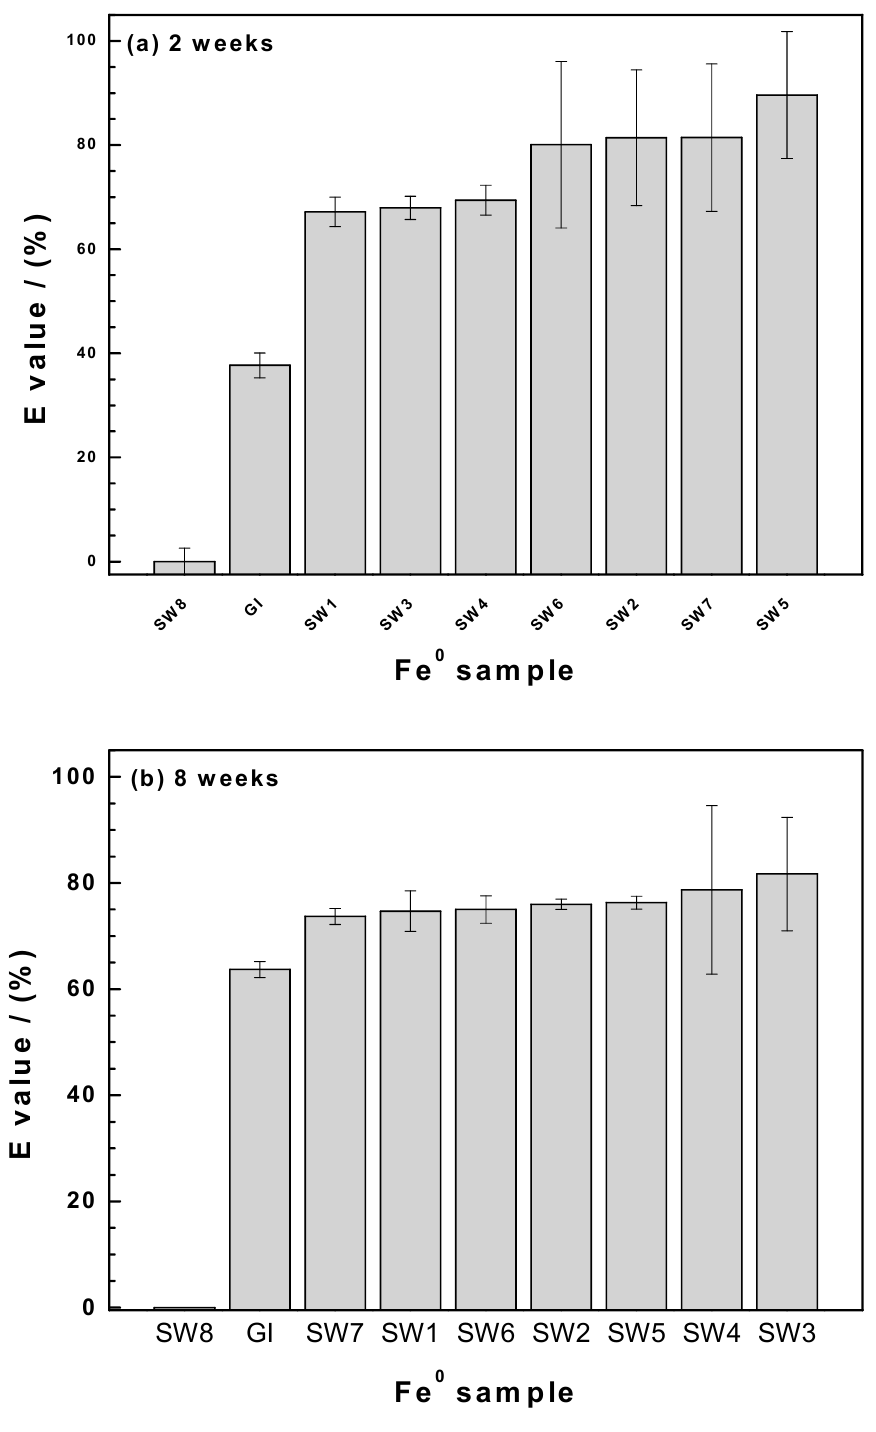
Figure 5. Extent of methylene blue discoloration for SW1–SW8 and GI after ( a ) two weeks and ( b ) eight weeks. Experimental conditions: 0.05 g Fe 0 ; V = 22 mL; [MB] = 10 mg / L; rotational shaking at 75 rotations per min.